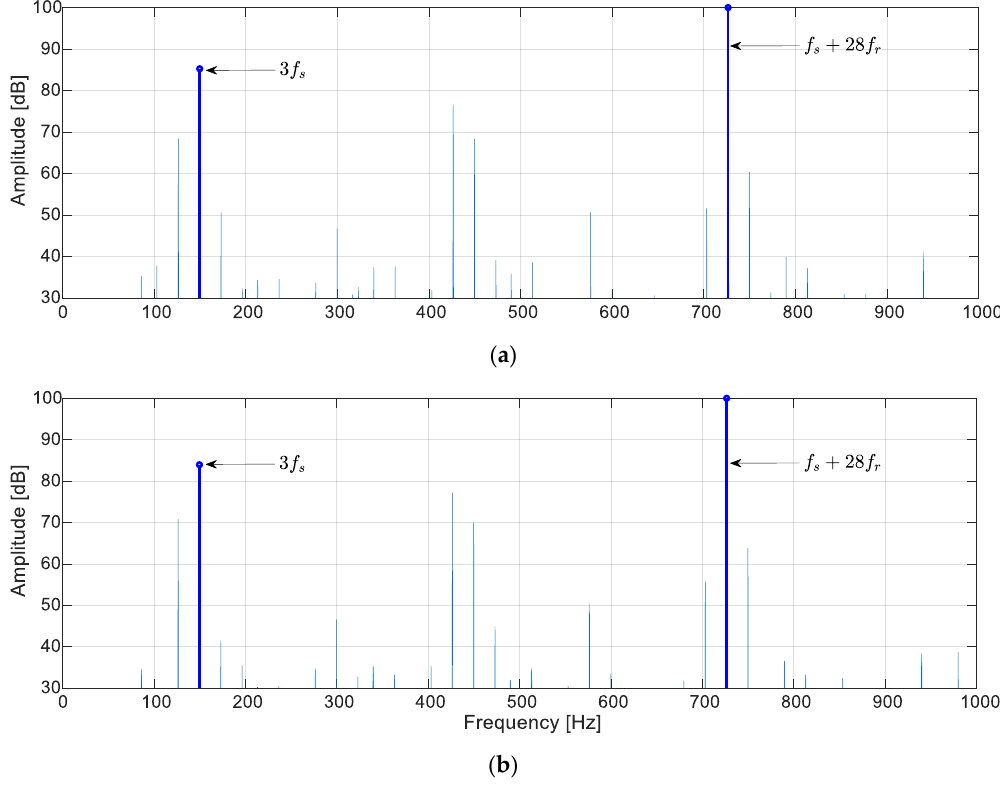
Figure 8. ZSC spectrum of a healthy motor for the stator winding connections: ( a ) delta connection; ( b ) wye connection with neutral wire.